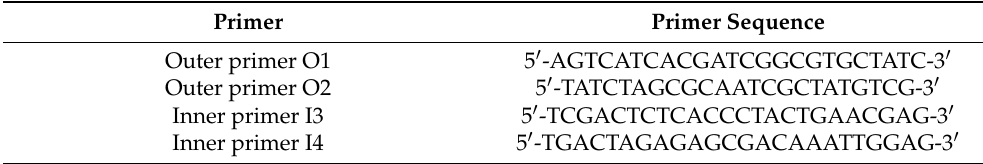
Table 3. Primers used for two-step PCR reaction for detection of HHV-6